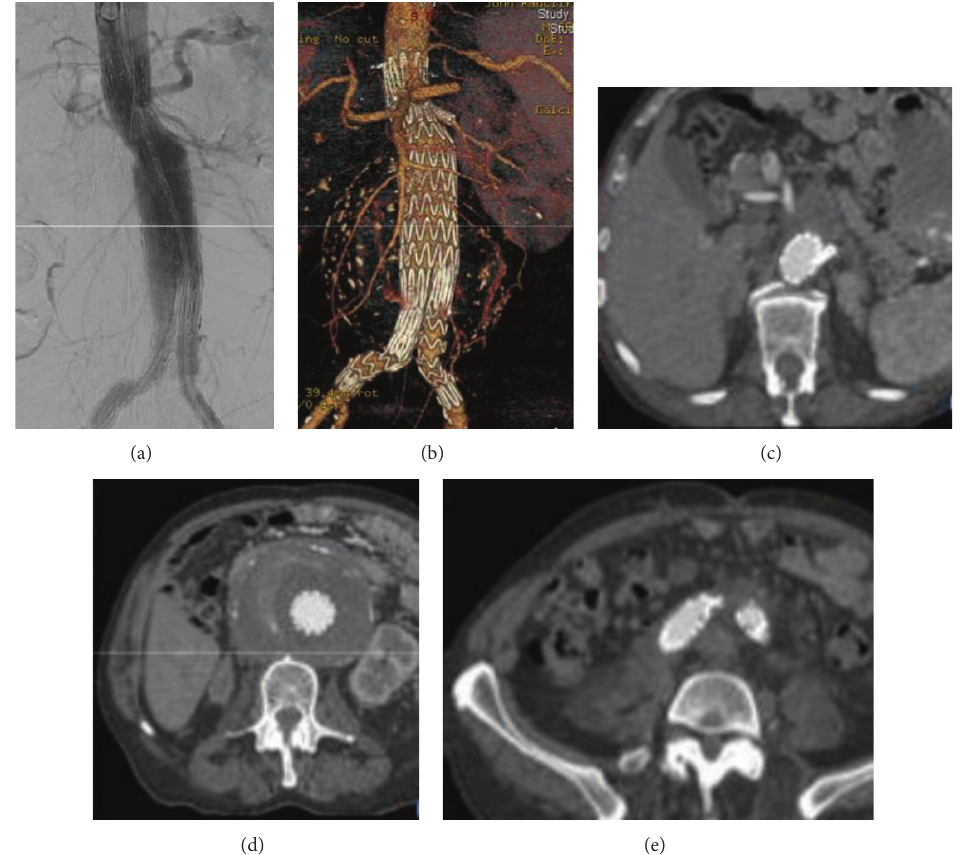
Figure 3: (a) Intraoperative completion angiography showing the good result of the ch-EVAR. (b) Reconstruction of postoperative CTA. Axial views of the postoperative CTA at the level of the origin of the left renal artery (c), mid-aneurysm (d), and bilateral common iliac arteries